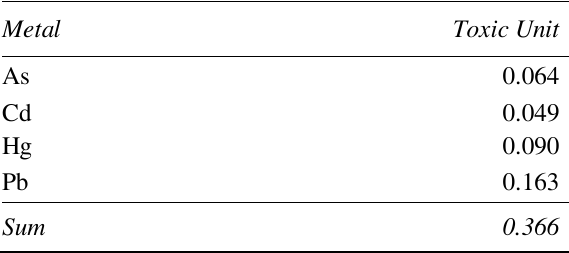
Table 1: Toxic Unit (TU) calculated for each